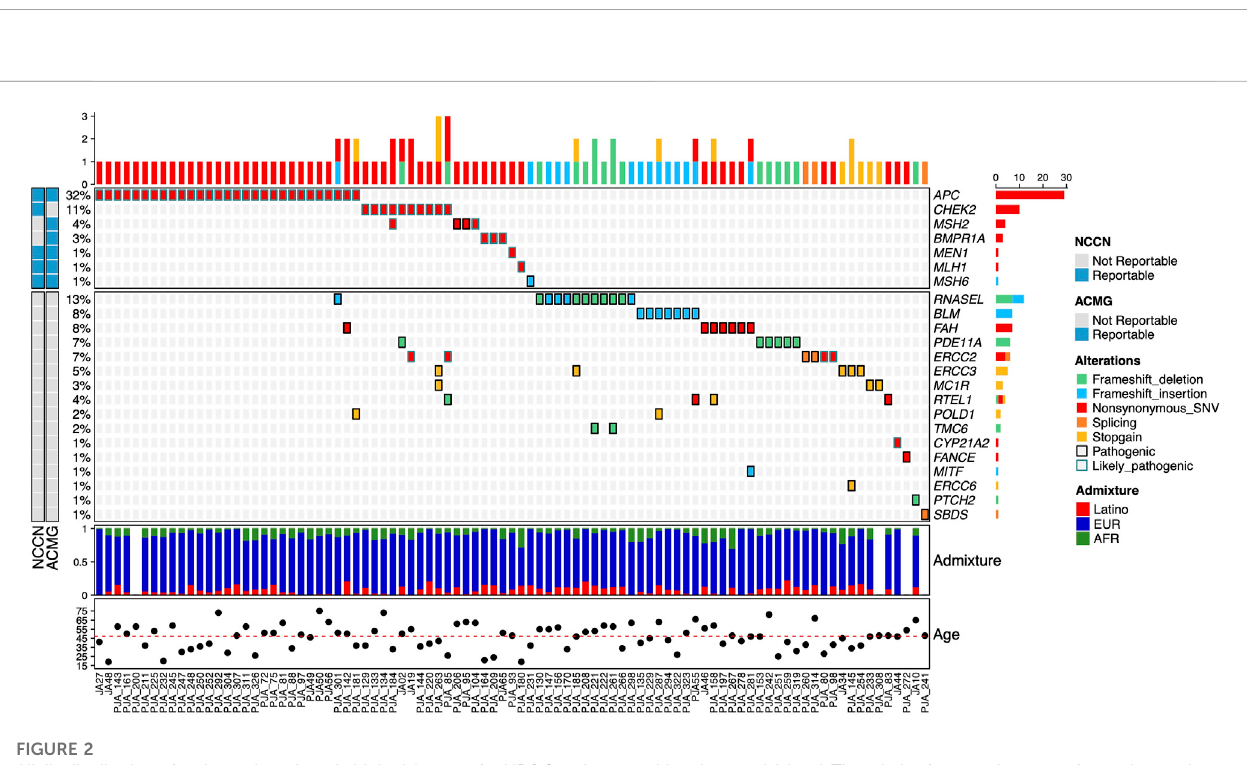
FIGURE 1 Principal component analysis showing ancestral composition of the AJ women recruited in comparison with the reference populations from 1000 G. PJA, Population of Mexican Ashkenazi Jews represented by yellow dots. POP, Populations, GBR, British, FIN, Finnish, IBS, Iberian, CEU, Northern and Western European, TSI, Toscani, MXL, Mexican, PEL, Peruvian, CLM, Colombian, PUR, Puerto Rican, YRI, Yoruba.